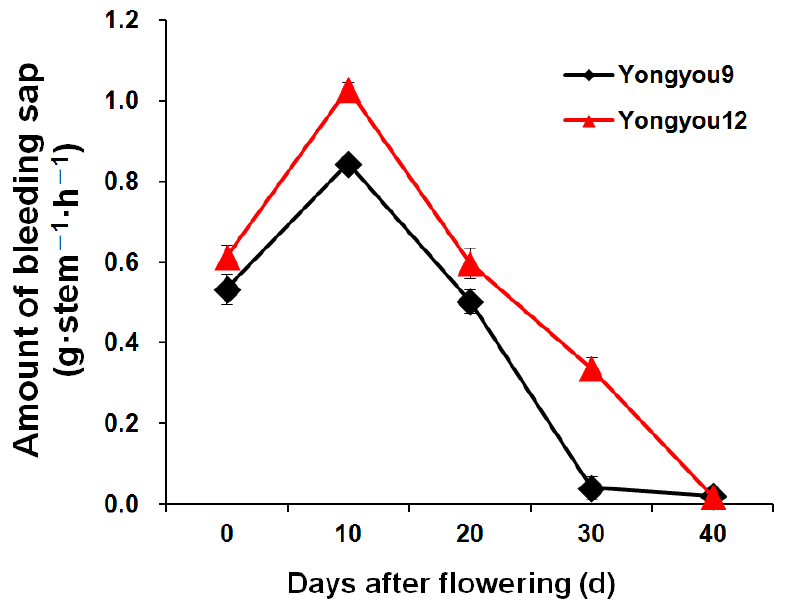
Figure 11. Amount of bleeding sap collected from rice roots after flowering. Error bars denote ± standard deviation ( n = 3). Table 2. Correlations of the Ratio of Panicle Weight to Total Weight/grain Yield with the Agronomy Traits and Physiological